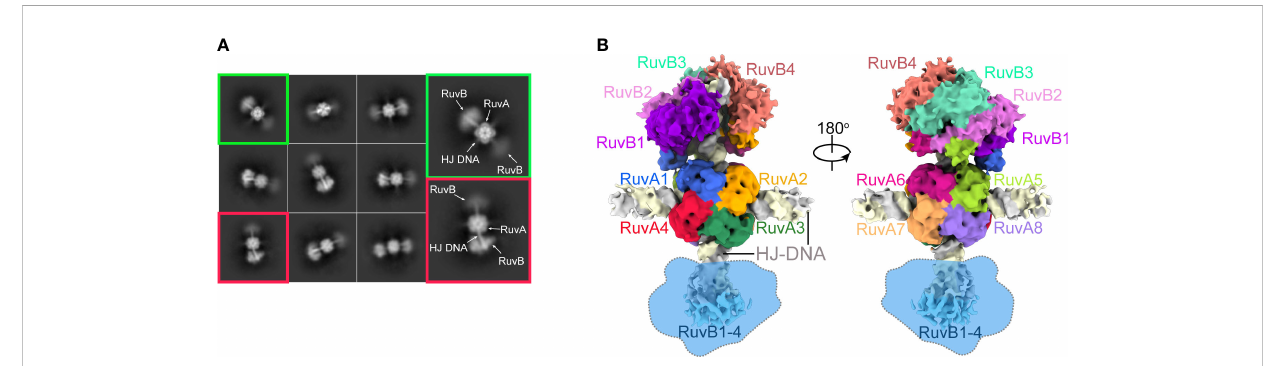
FIGURE 2 Cryo-EM of the PaRuvAB-HJ complex. (A) Representative 2D classes of the PaRuvAB-HJ complex. (B) Cryo-EM map for the PaRuvAB-HJ complex. The components within the complex are labeled and colored as indicated. The dashed blobs indicate the less resolved map of the other RuvB motor. All structural fi gures in this study, unless otherwise indicated, use the same color and labeling schemes.